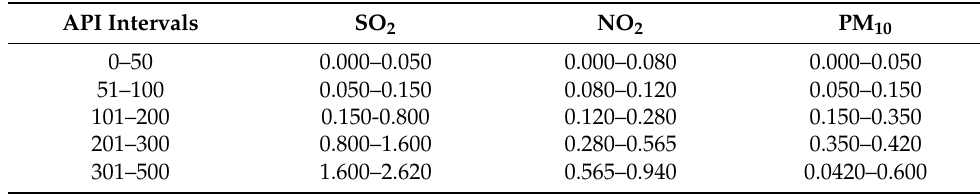
Table 5. API concentration